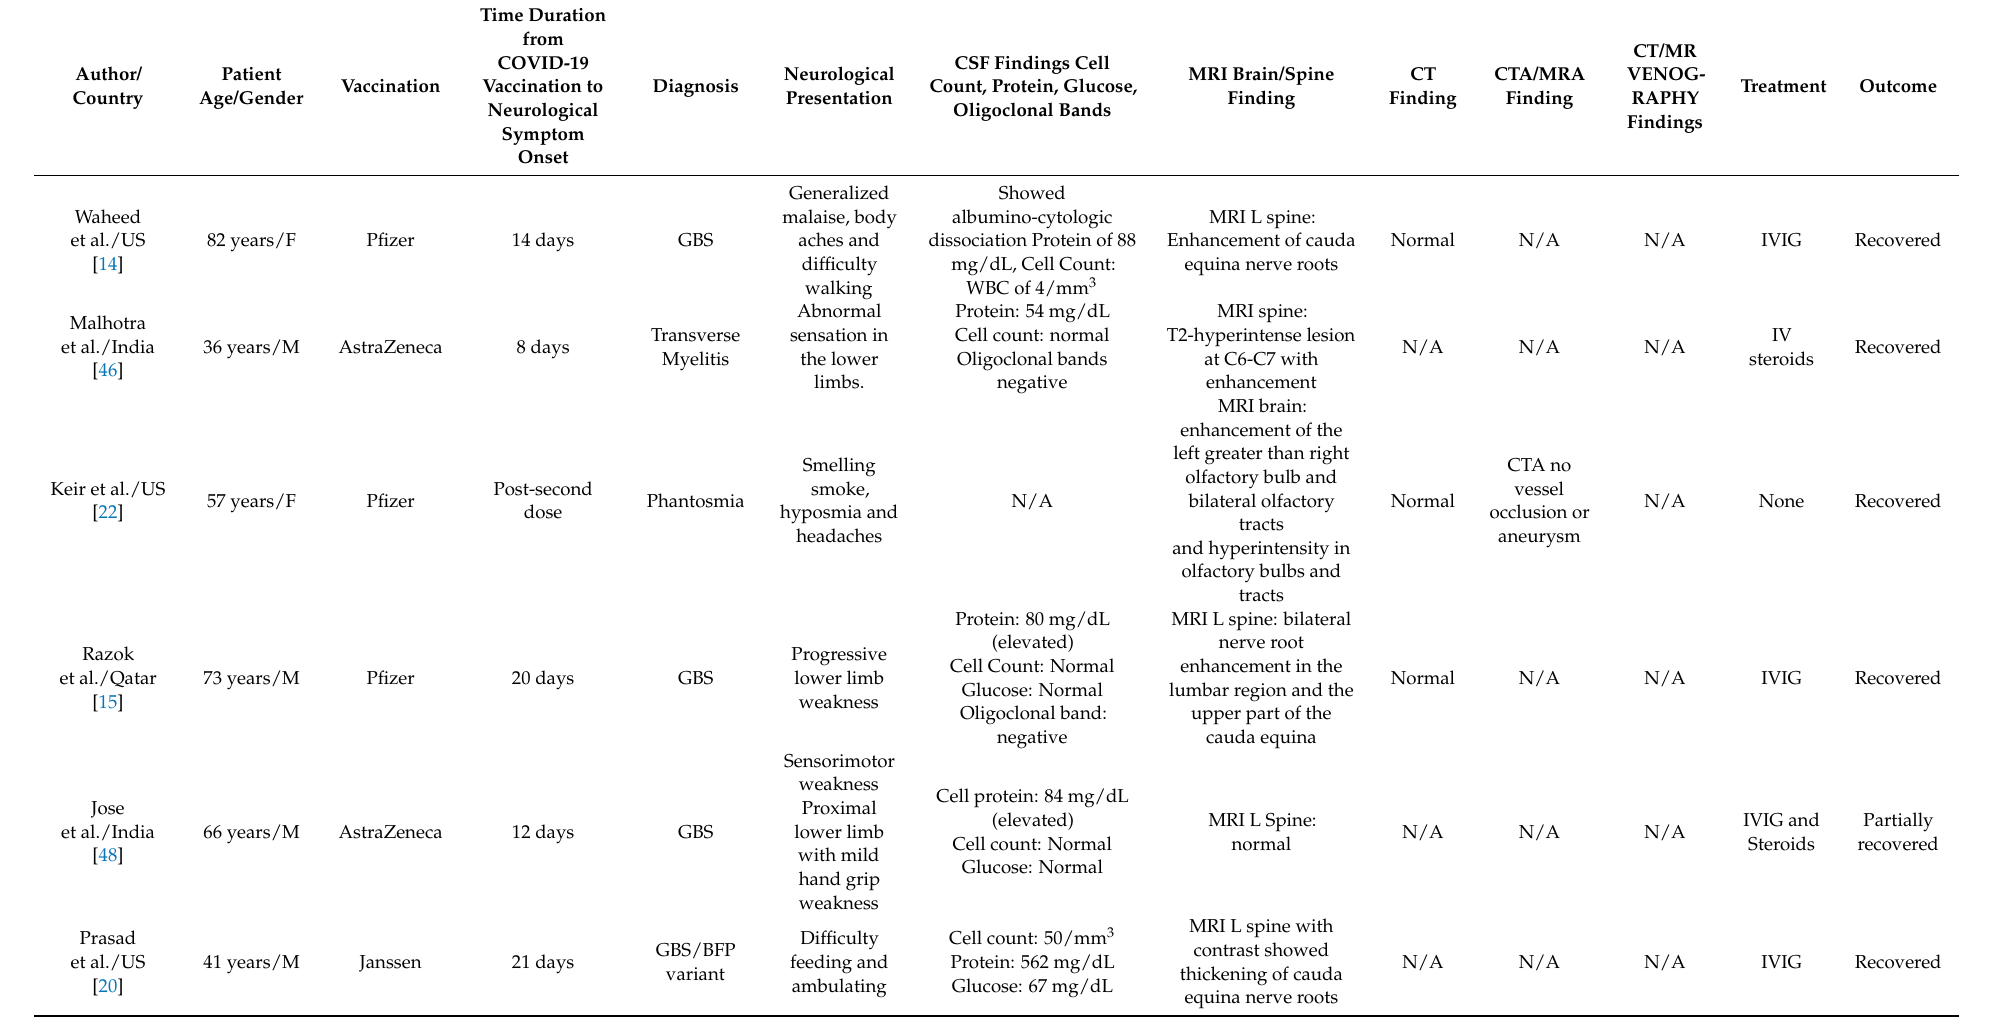
Table 1. Study origin, demographics, CSF, MRI findings, and outcomes in COVID-19 vaccination and CNS inflammatory